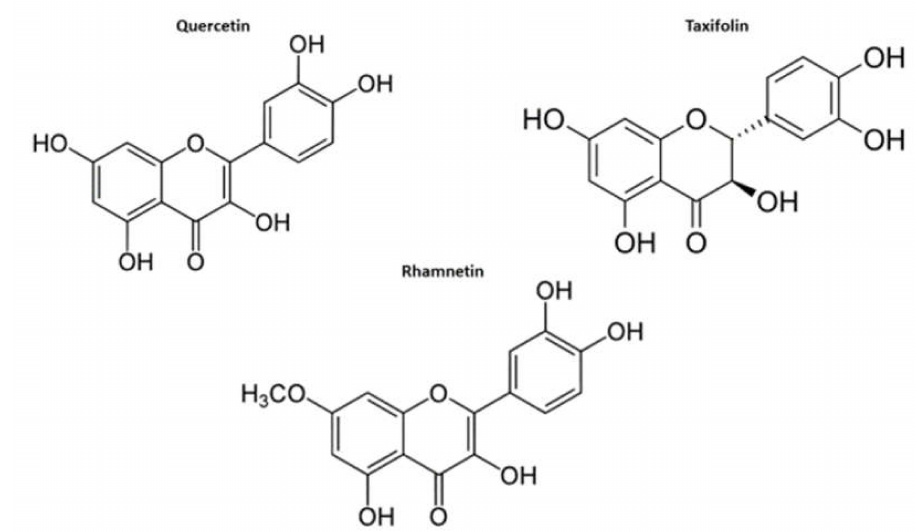
Figure A1. Similarity of chemical structures of the Quercetin, Taxifolin, and Rhemnetin. Taxifolin and rhemnetin have been identified in the recent a chemical library of over 687 million compounds for binding at the recently solved crystal structure of the main protease of SARS-CoV-2 coronavirus (Fischer et al., 2020. https: // doi.org / 10.26434 / chemrxiv.11923239.v2 ) among the top-scoring candidate inhibitors of the SARS-CoV-2 main